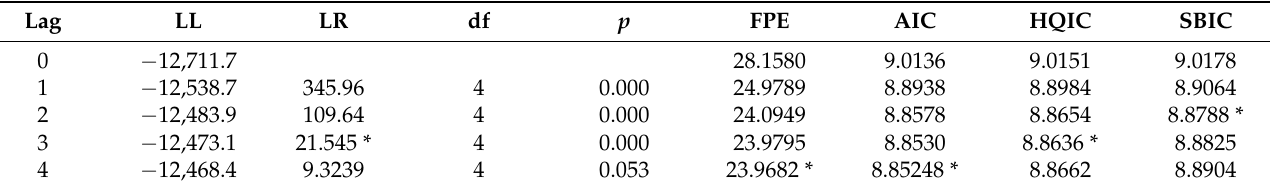
Table 5. Lag order test for WTI and SMF